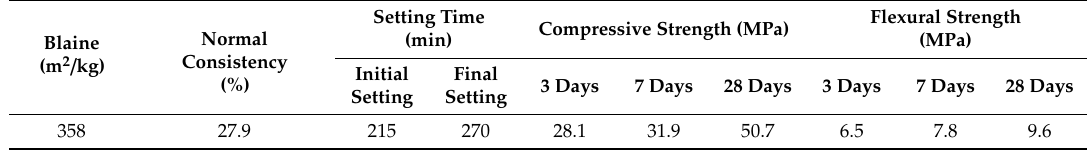
Table 1. Physical properties of the cement. Table 2. Chemical composition of cement.